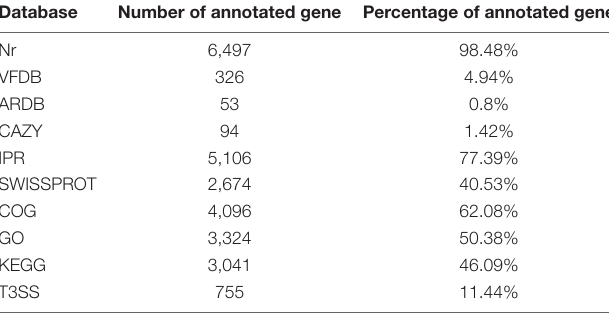
TABLE 3 | Annotation of gene in venom